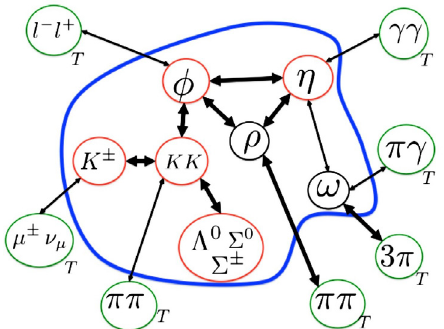
Figure 1. Principal strangeness abundance changing processes in the hadronic Universe T < T h = 150MeV. Within the (blue) boundary we see hadronic particles expected to fall out of abun- dance (chemical) equilibrium. The red circles within this do- main represent strangeness-carrying mesons, black non-strange mesons of importance in creation of strangeness. Particles in green circles indicating their full equilibrium (subscript T ) are seen outside this (blue) boundary domain.